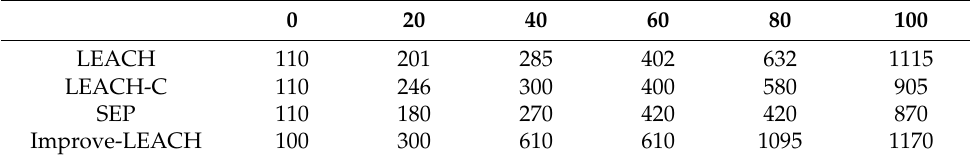
Table 7. The number of rounds experienced when the number of nodes die.